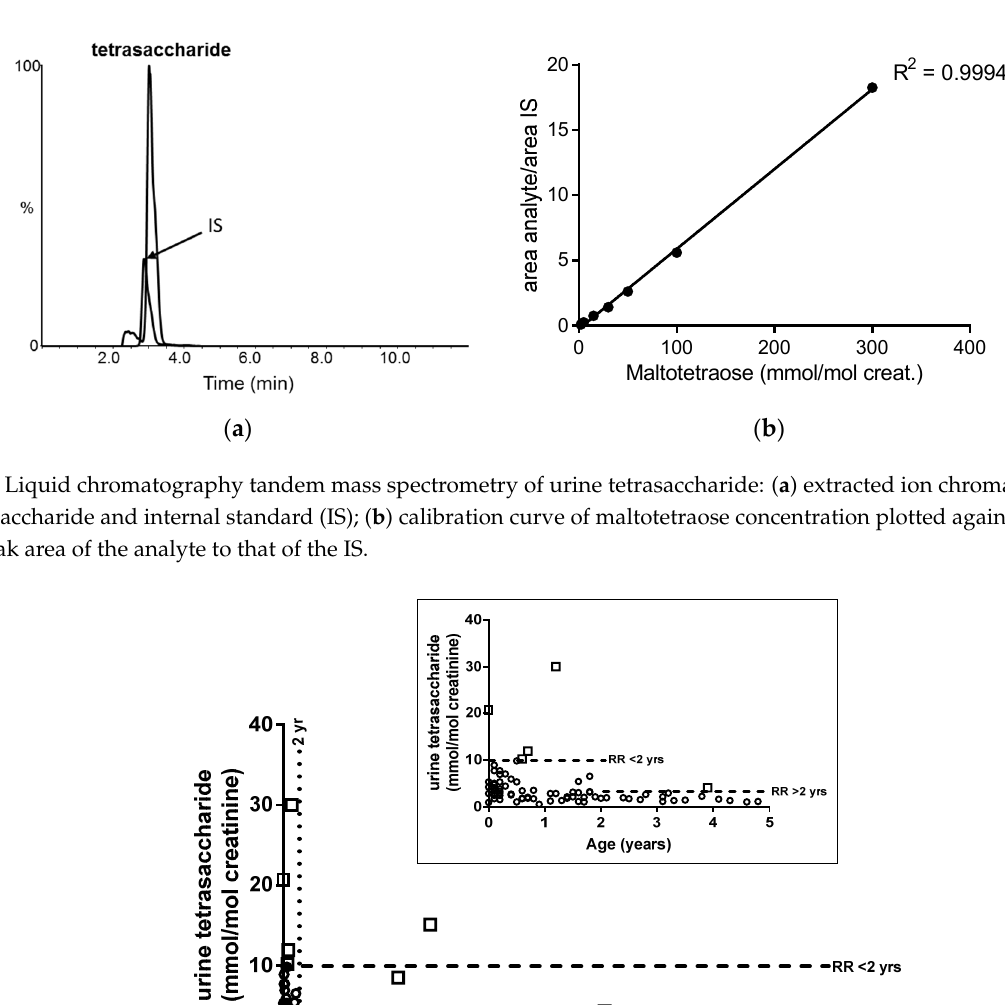
Figure 1. Liquid chromatography tandem mass spectrometry of urine tetrasaccharide: ( a ) extracted ion chromatogram of the tetrasaccharide and internal standard (IS); ( b ) calibration curve of maltotetraose concentration plotted against the ratio of the peak area of the analyte to that of the IS.